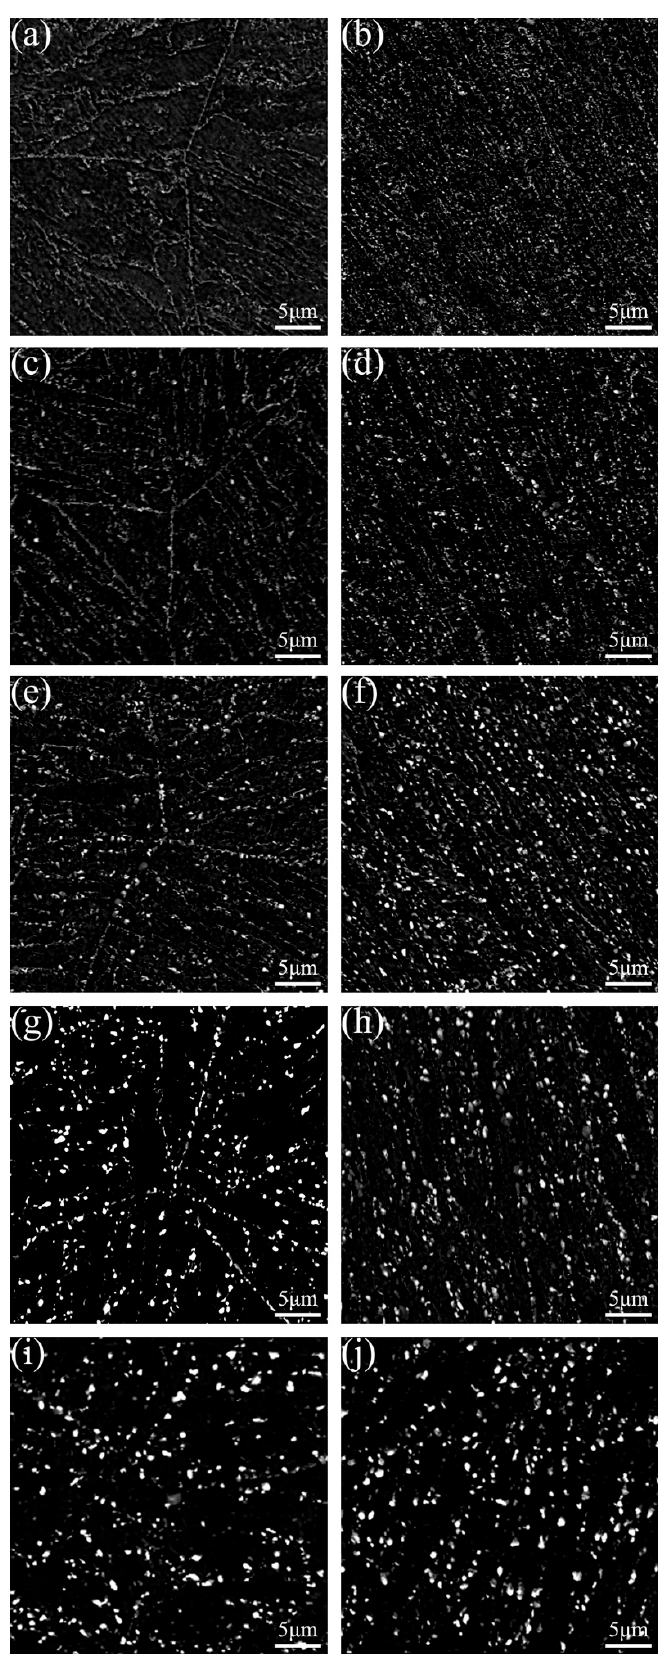
Figure 4. SEM images of 9Cr-3W-3Co steel after creep tests at 650 °C: specimens ruptured after ( a , b ) 134 h, ( c , d ) 837 h, ( e , f ) 3037 h, ( g , h ) 6667 h, ( i , j ) 17,991 h. ( a , c , e , g , i ) are from grip areas; ( b , d , f , h , j ) are from gauge areas.